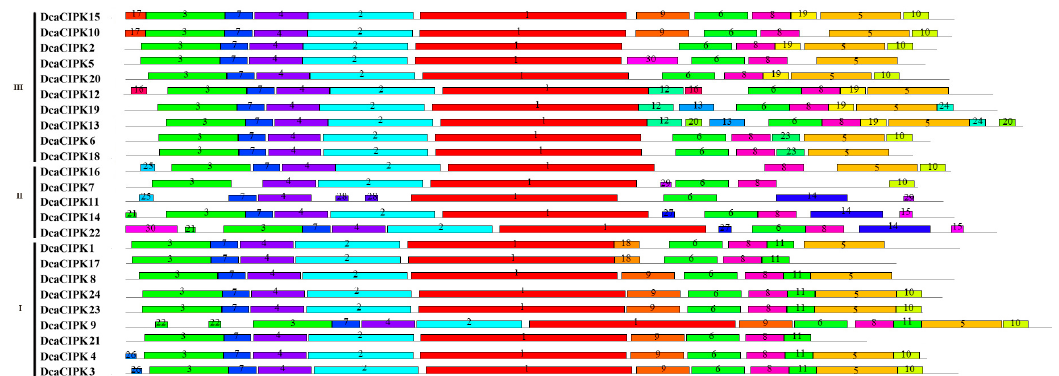
Figure 2. Conserved motifs in D. catenatum CIPK proteins. All motifs were identified by MEME with the 24 complete protein sequences of the CIPKs.